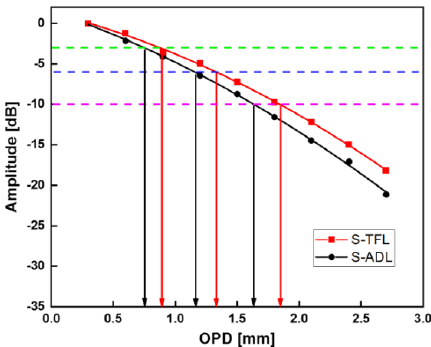
Figure 10. Sensitivity roll-o ff of the spectral domain optical coherence tomography (SD-OCT) system according to the OPD when using the S-ADL and the